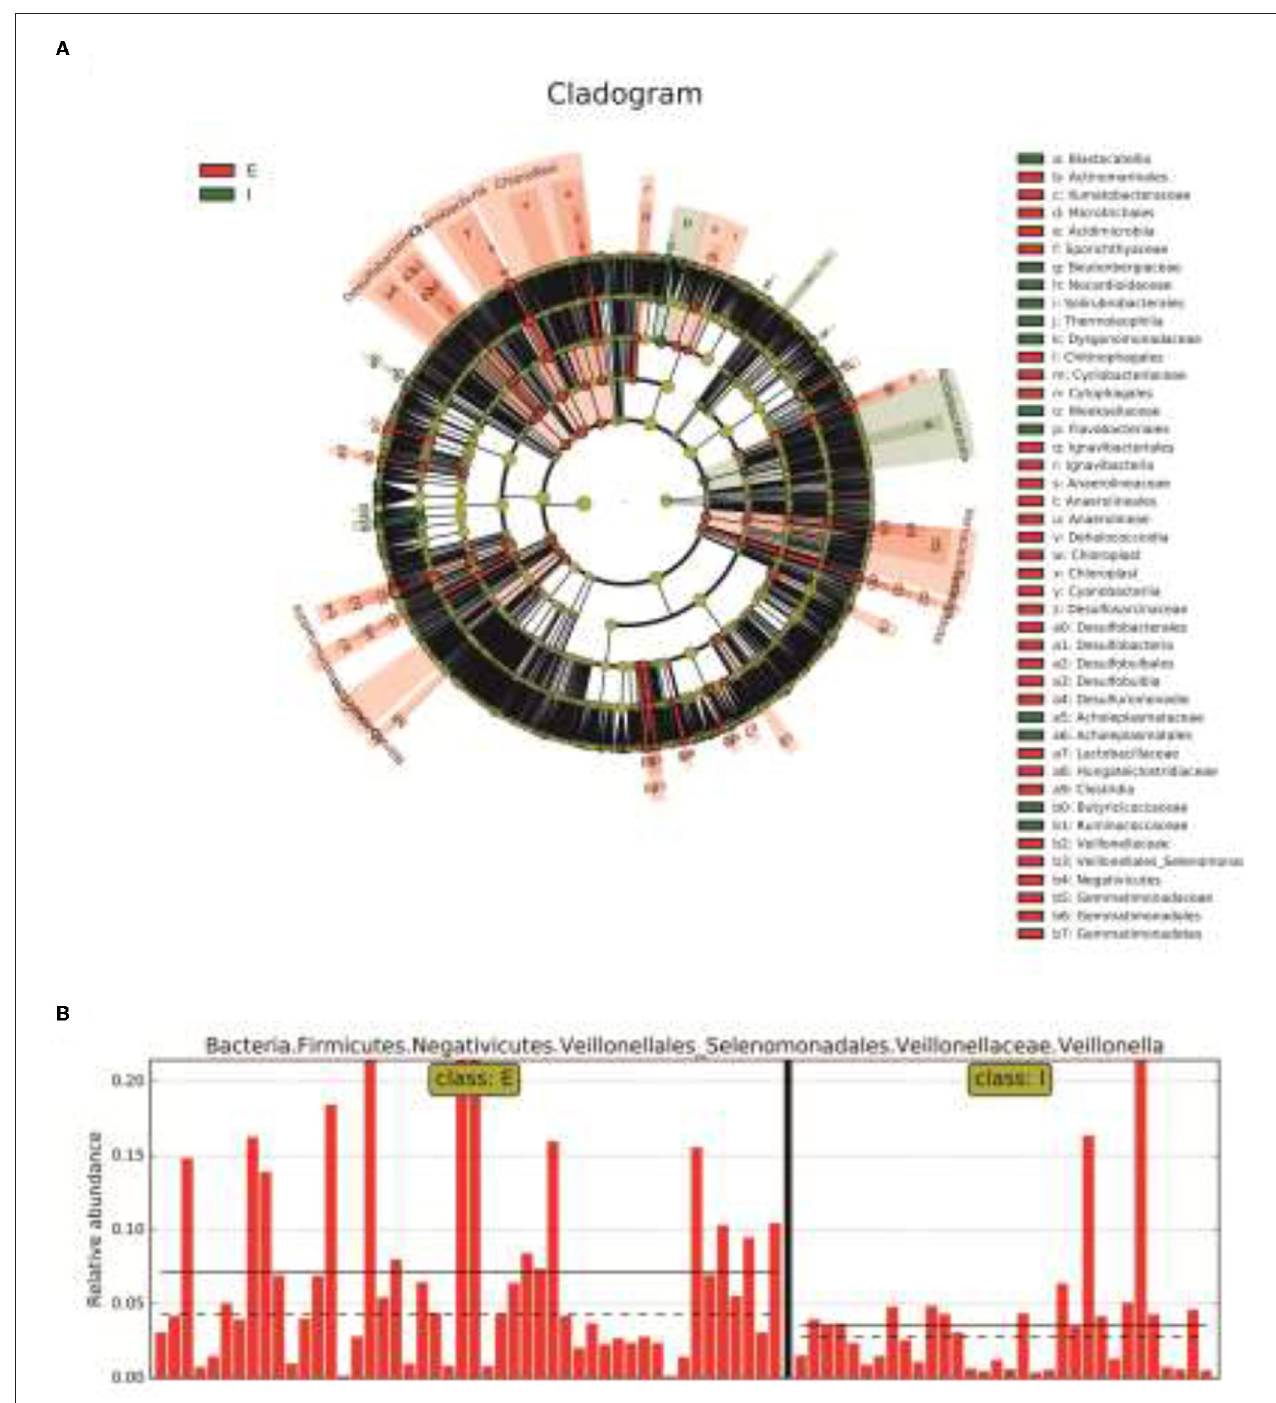
FIGURE 4 | The LEfSe analysis was used to estimate the abundance influence of each strain on the difference. (A) , Cluster tree analysis. Red represents the group of COPD frequent exacerbators, green represents the group of COPD infrequent exacerbators, and nodes of different colors represent the importance of the microbiome in the representated group. The yellow nodes indicate the microbiota that did not play an important role in both groups. (B) , The abundance analysis of Veillonella in COPD frequent exacerbators and COPD infrequent exacerbators. E represented COPD frequent exacerbators; I represented COPD infrequent exacerbators. LEfSe, linear discriminant analysis effect size; COPD, chronic obstructive pulmonary